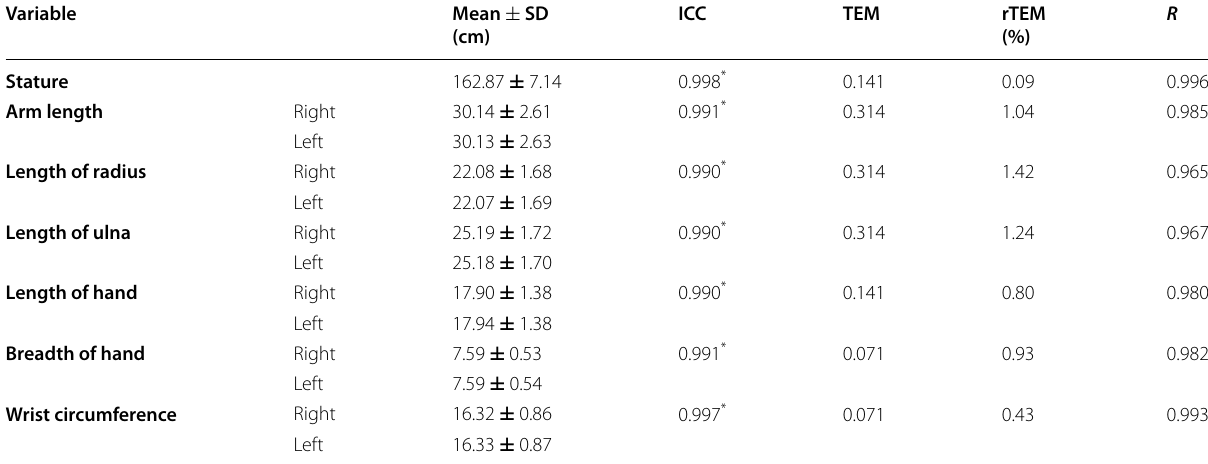
ICC intra-class correlation coefficient, TEM technical error of measurement, rTEM relative technical error of measurement, R coefficient of reliability * Significant at p < 0.001 level